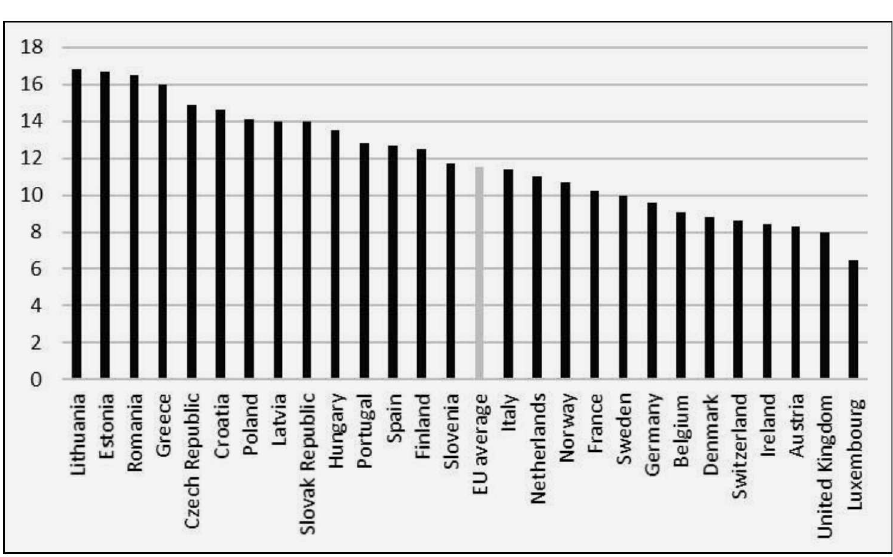
Average age (in years) of passenger cars in the V4 countries compared to some European countries, 2019